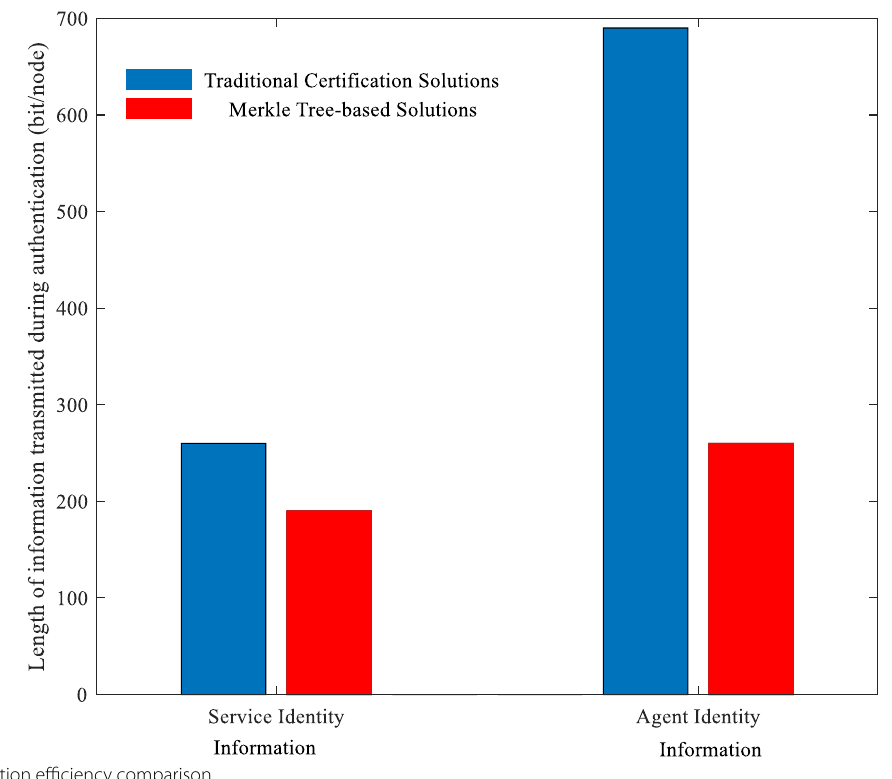
Fig. 12 Certification efficiency